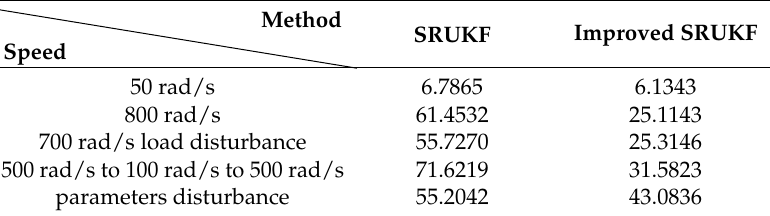
Table 2. RMSE of speed estimation.